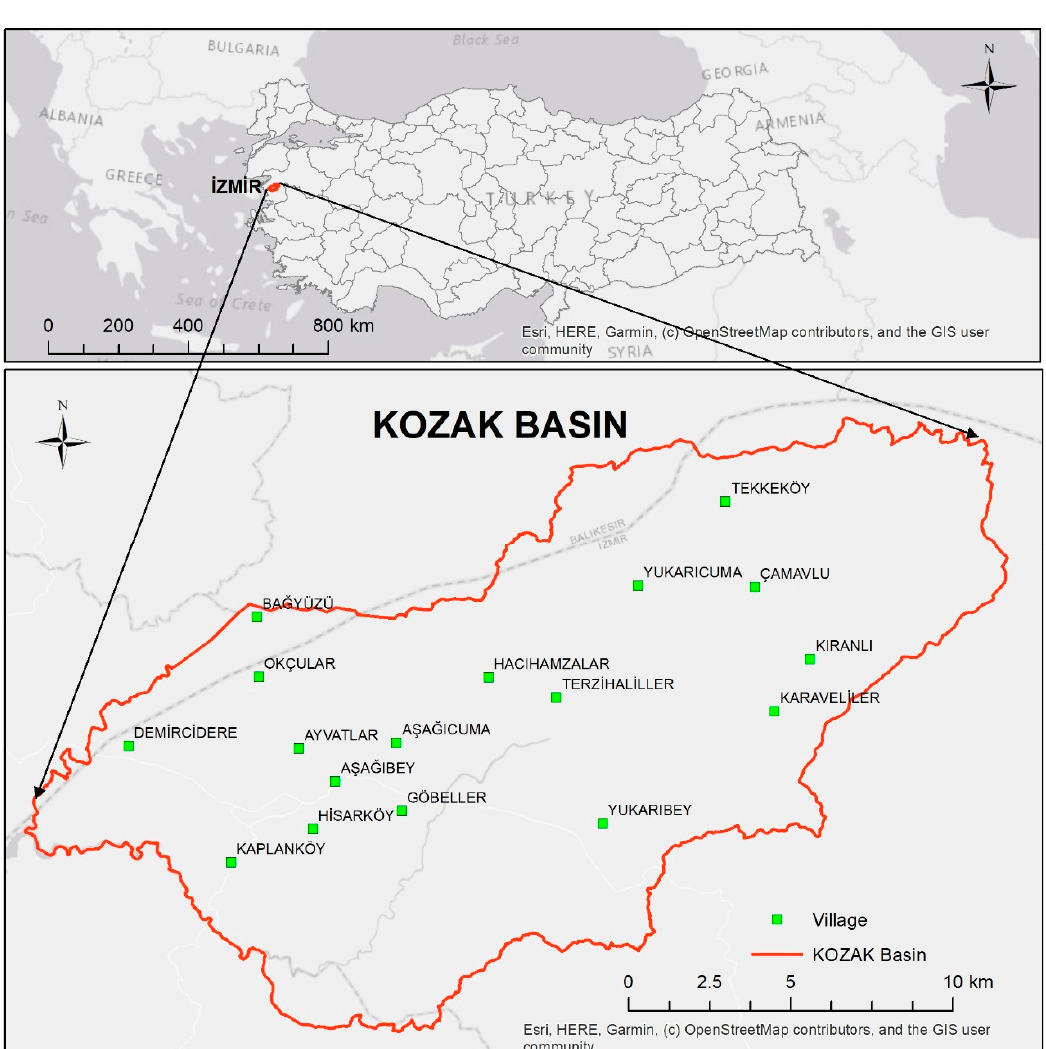
Figure 1. Map of the study area, including the villages selected for the study.